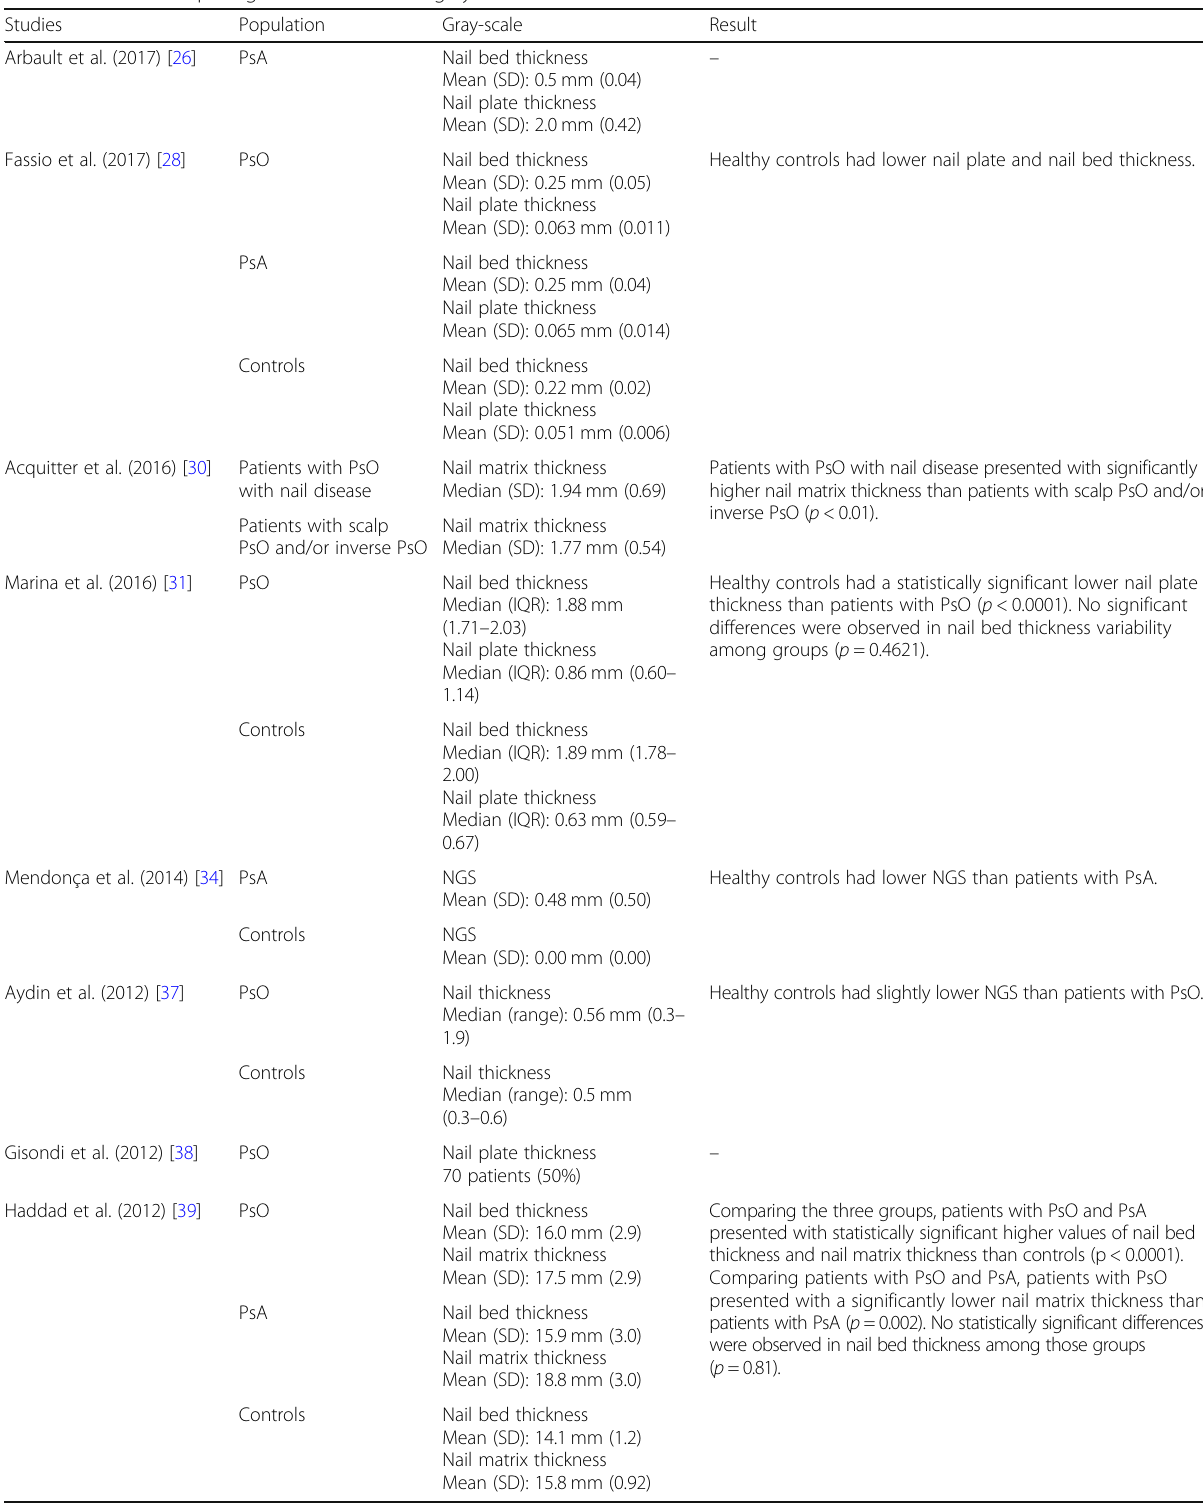
Table 3 Studies comprising measurements on gray-scale